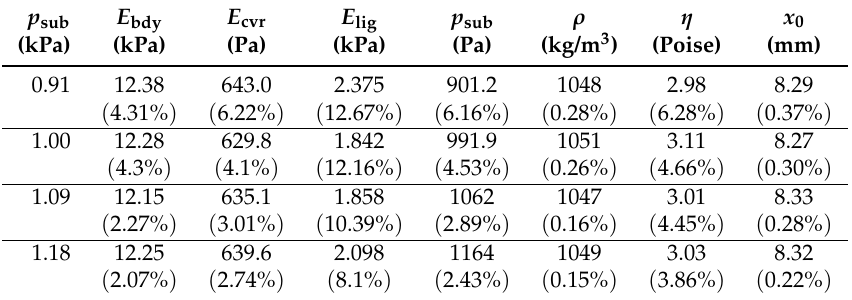
Table 5. Material properties estimates for varying subglottal pressures with medial compression. The associated estimate uncertainties as a percentage of the estimate values are in